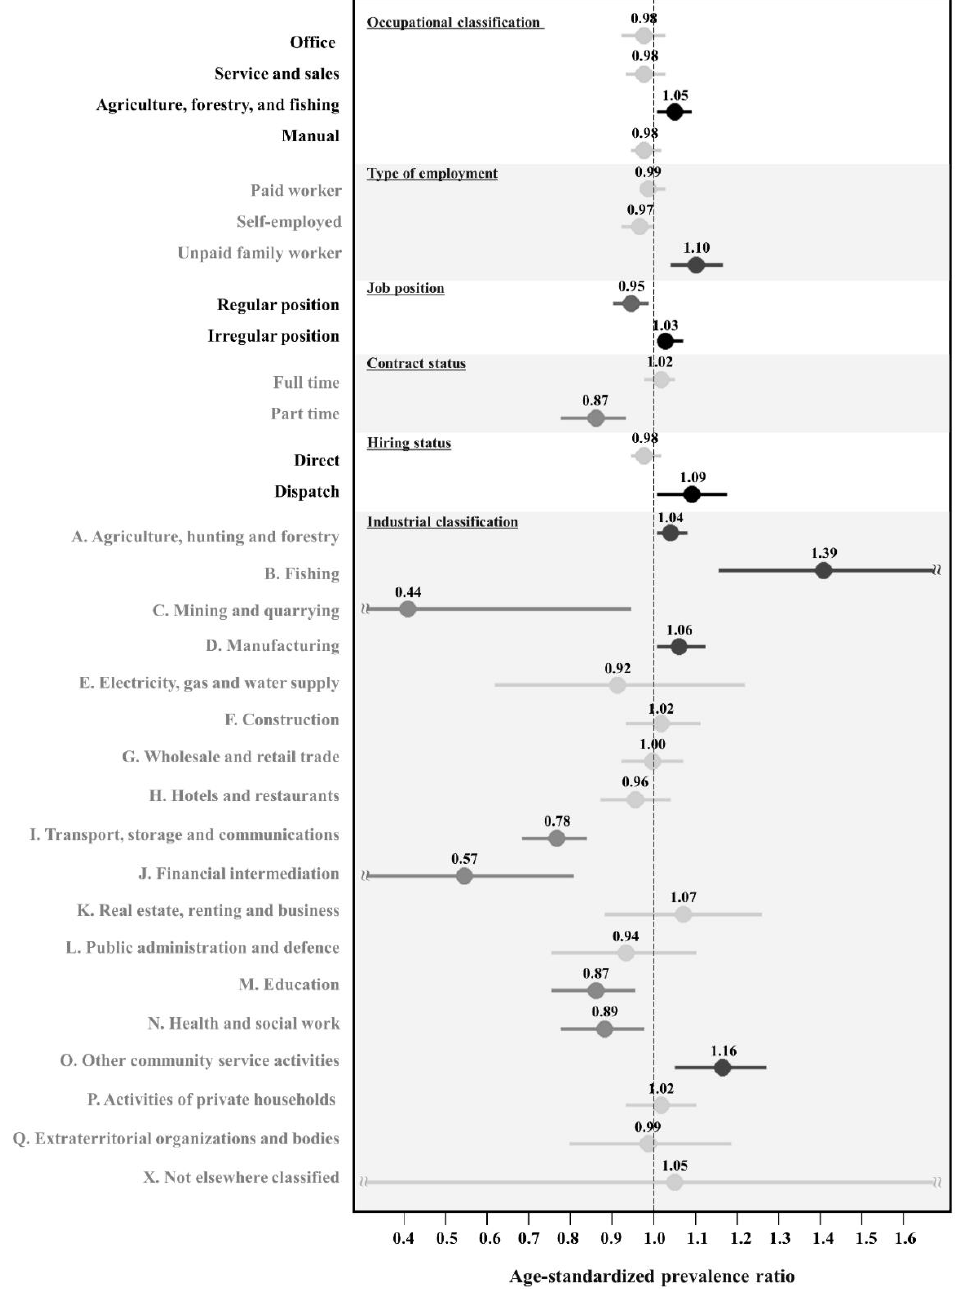
Figure 2. Age-standardized prevalence ratio (SPR) and 95% confidence interval of noncompliance of medication adherence by occupational characteristics among workers (60,002 person years). Black indicates statistically significant positive SPR. Grey indicates statistically significant negative SPR. Light grey indicates non-statistically significant SPR.